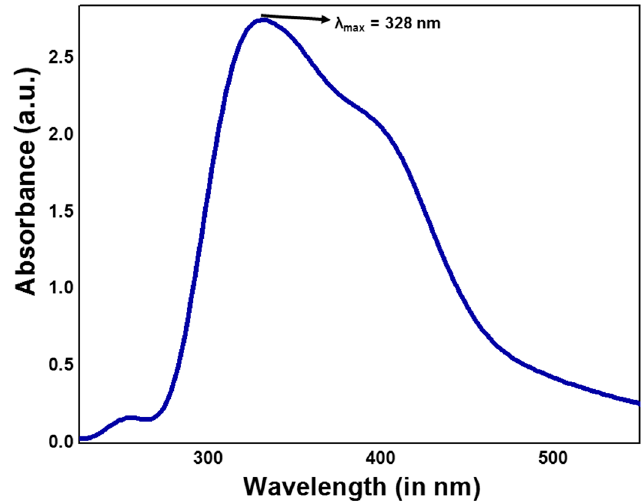
Figure 2. UV–visible spectrum of the as-prepared ZnONPs, measured in the dispersed form in ethanol solution showing λ max = 328